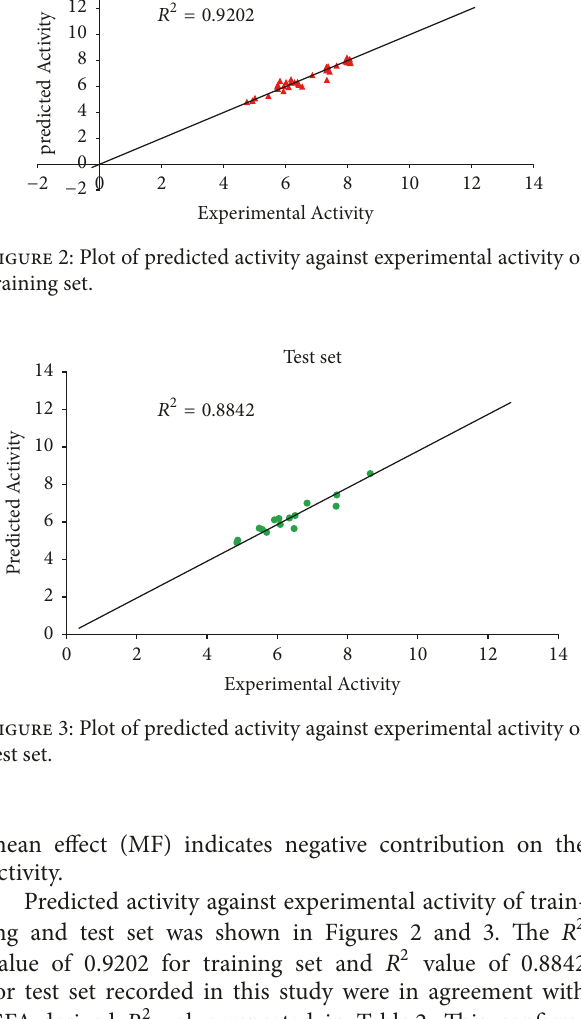
Figure 5: The Williams plot of the standardized residuals versus the leverage